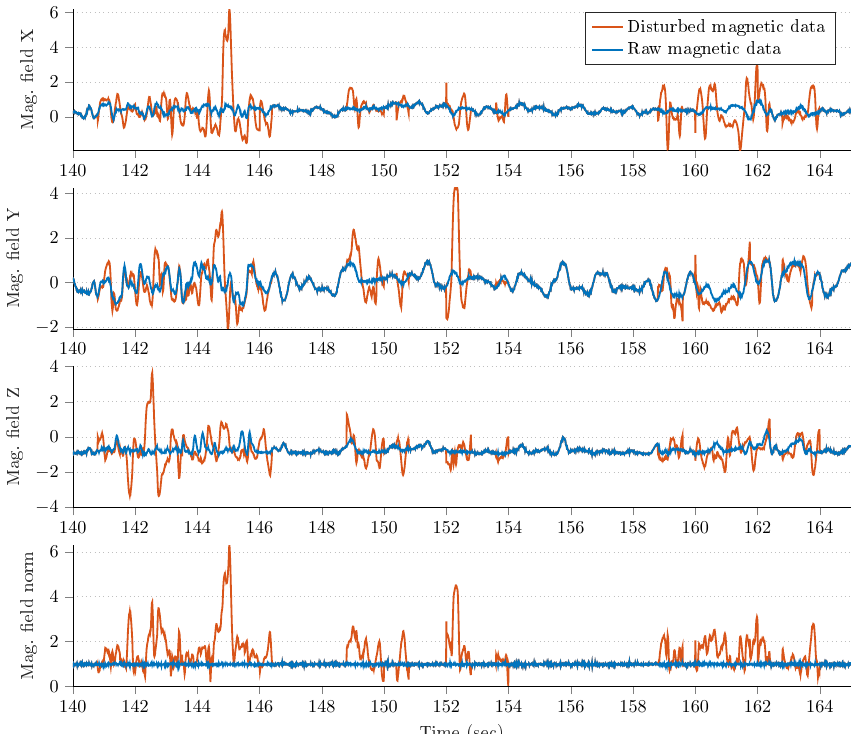
Figure 7. Magnetic field measurements before and after the application of the magnetic perturbation generator